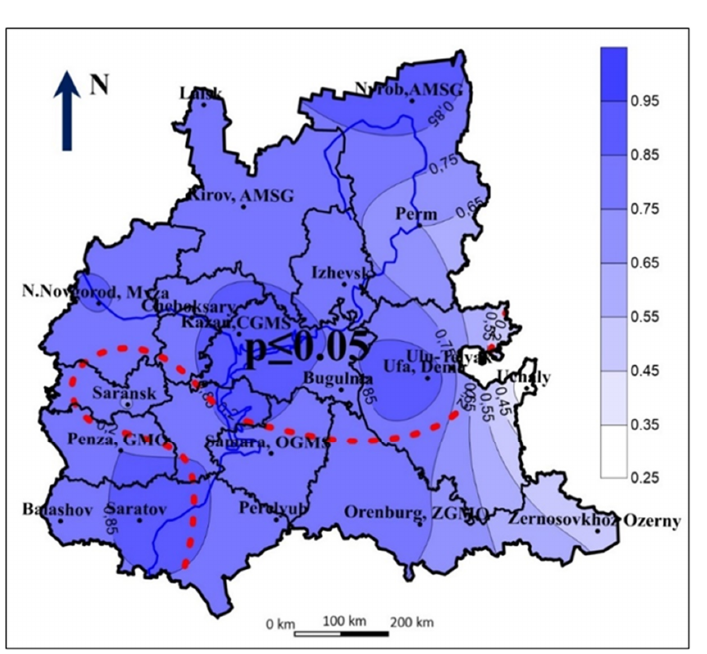
Figure A1. Linear trend slope coefficients (LTSC, °C/10 years) for January average air temperature and their statistical significance in the Volga Federal District during 1966–2021.